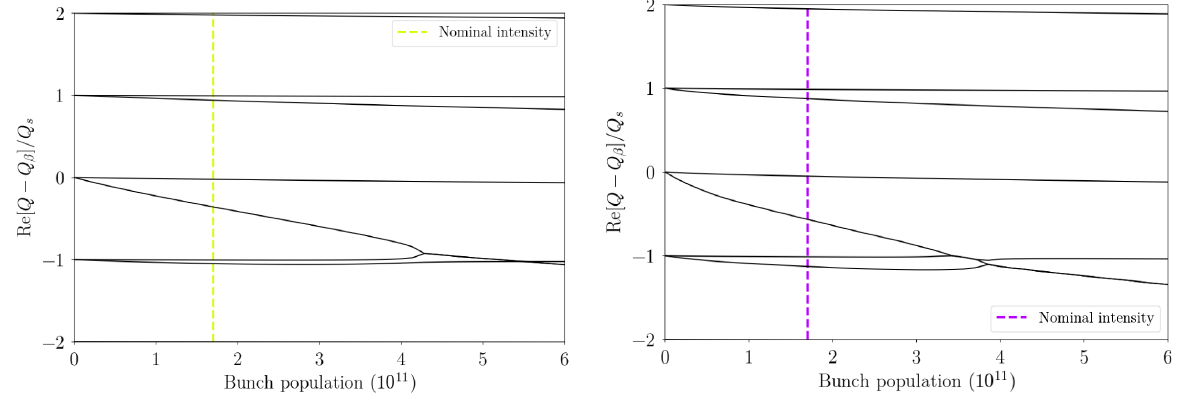
FIG. 10. Real part of the frequency of the first coherent oscillation modes as a function of bunch population with 50 nm (left side) and the 1 μ m of coating thickness for material B (right side). The curves are obtained with DELPHI code by using the machine parameters of Table I at the lowest machine energy and with the bunch length given by P Y HEADTAIL at different intensities. The dashed vertical lines correspond to the nominal bunch